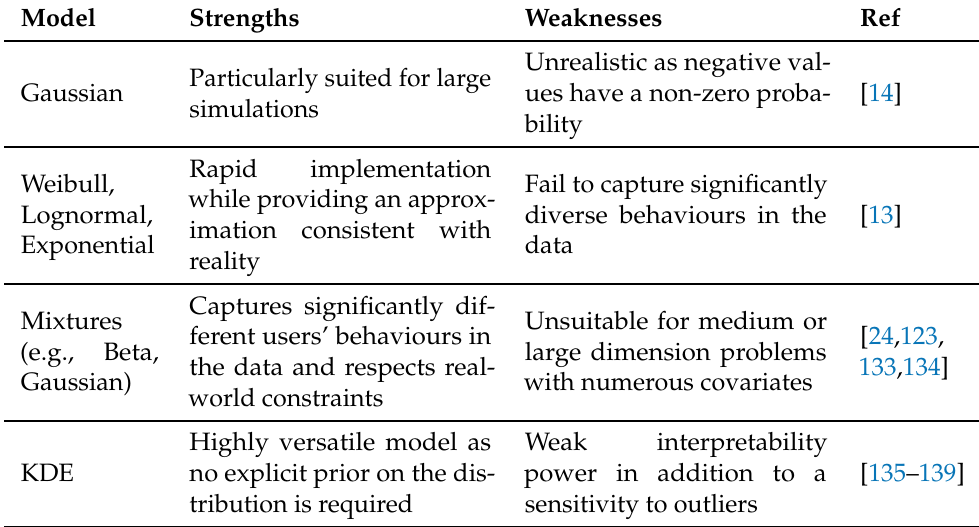
Table 2. Statistical characterization models for EV